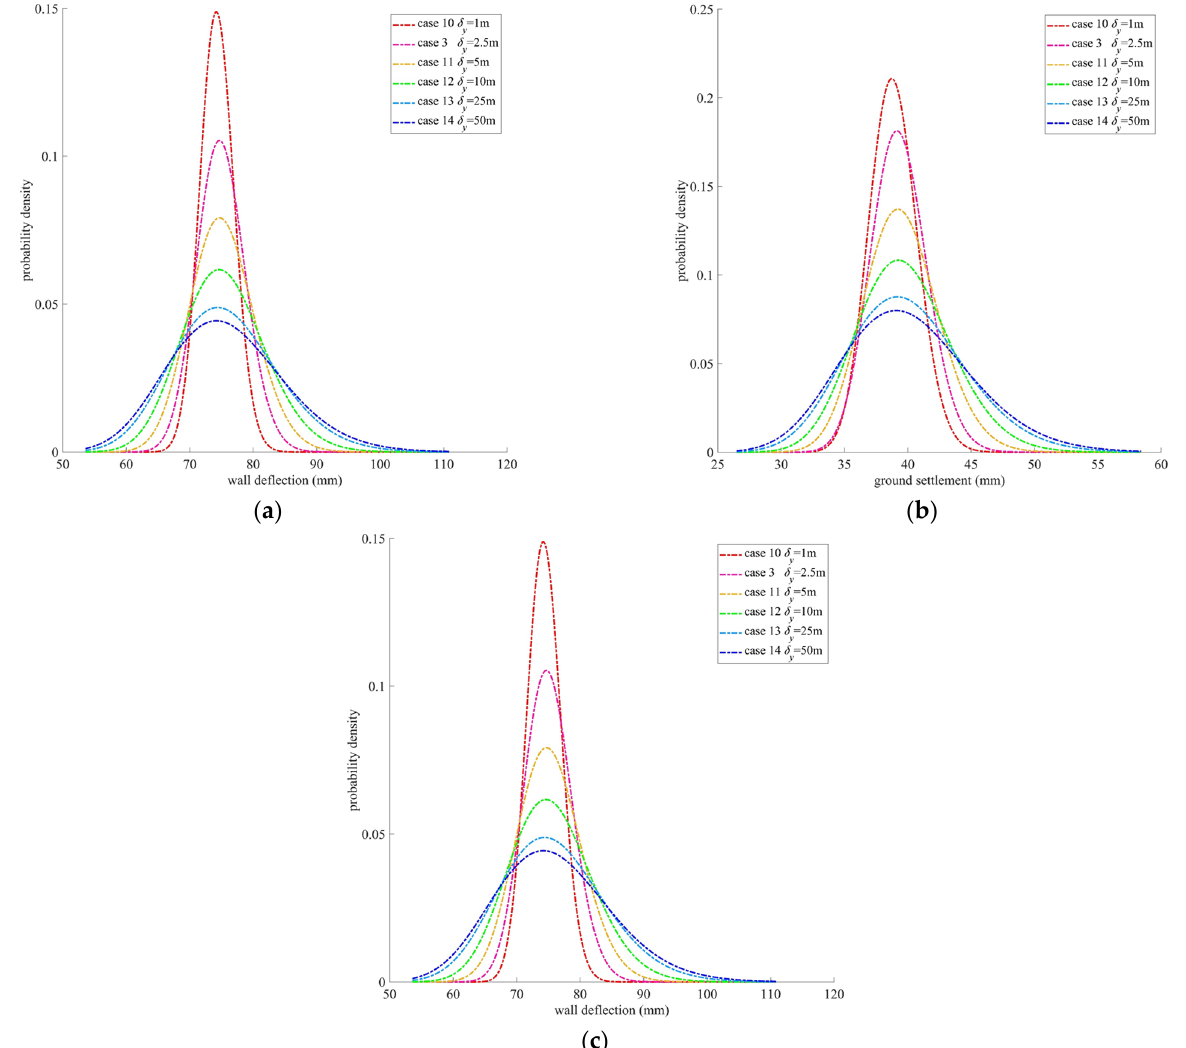
Figure 9. Effect of δ y on distribution of excavation responses: ( a ) histogram of wall deflection with different δ y ; ( b ) histogram of ground settlement with different δ y ; ( c ) histogram of basal heave with different δ y .